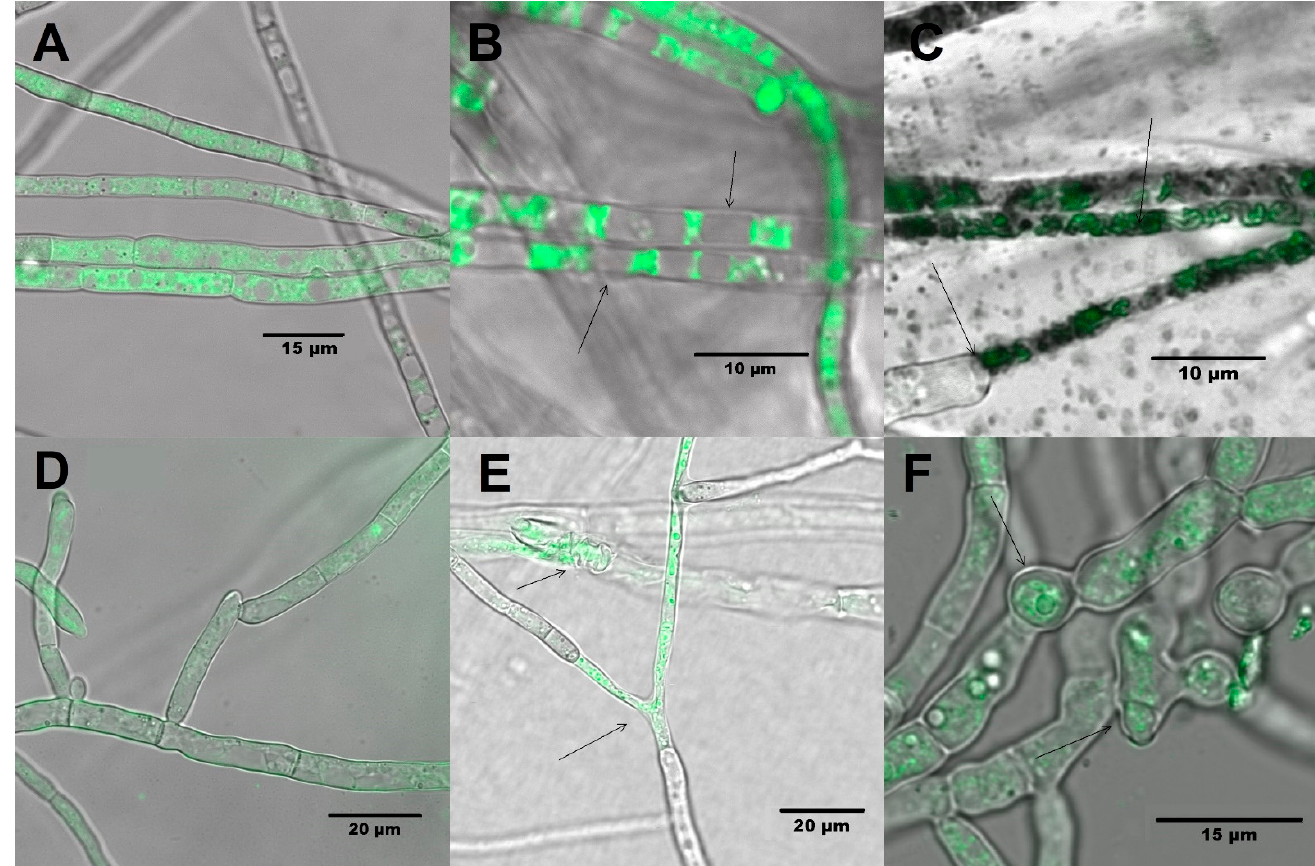
Figure 4. Mycelia of A. alternata without treatment ( A ) and treated ( B , C ) with a mixture of cell-free extracts of P. fluorescens and chitosan [50–1.5% ( v / v )]. Mycelia of F. solani without treatment ( D ) and treated ( E , F ) with the mixture of cell-free extracts of P. fluorescens with chitosan [50–1.5% ( v / v )]. With respect to the conidia of both treated fungi, as can be seen in Figure 5A,D, they are well-shaped and formed conidia, with the cell wall and membrane smooth and dis- tinctive. In Figure 5B,C in the case of A. alternata, distorted conidia were observed. In Fig- ure 5E, in the case of F. solani, it was noticed that there were intracellular material and cell wall external modifications.